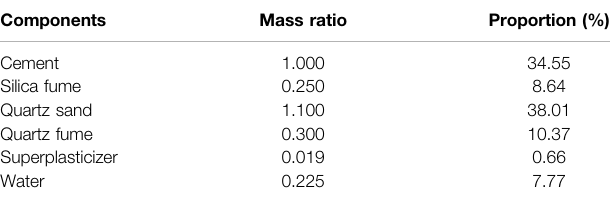
TABLE 1 | Mix ratio of